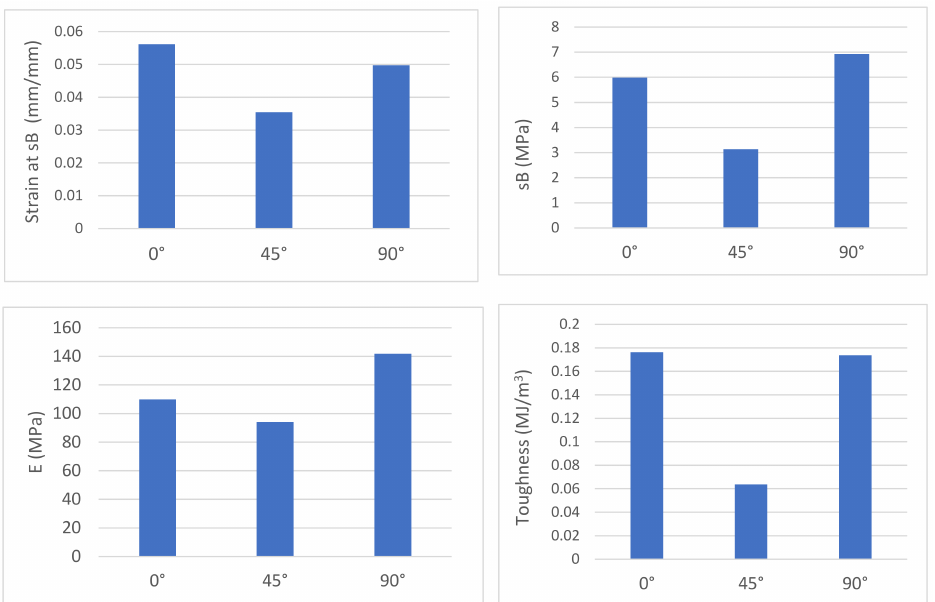
Figure 20. Strain at sB, Modulus of Elasticity, sB value and toughness of lattice structure #1 for different cell mapping angles.